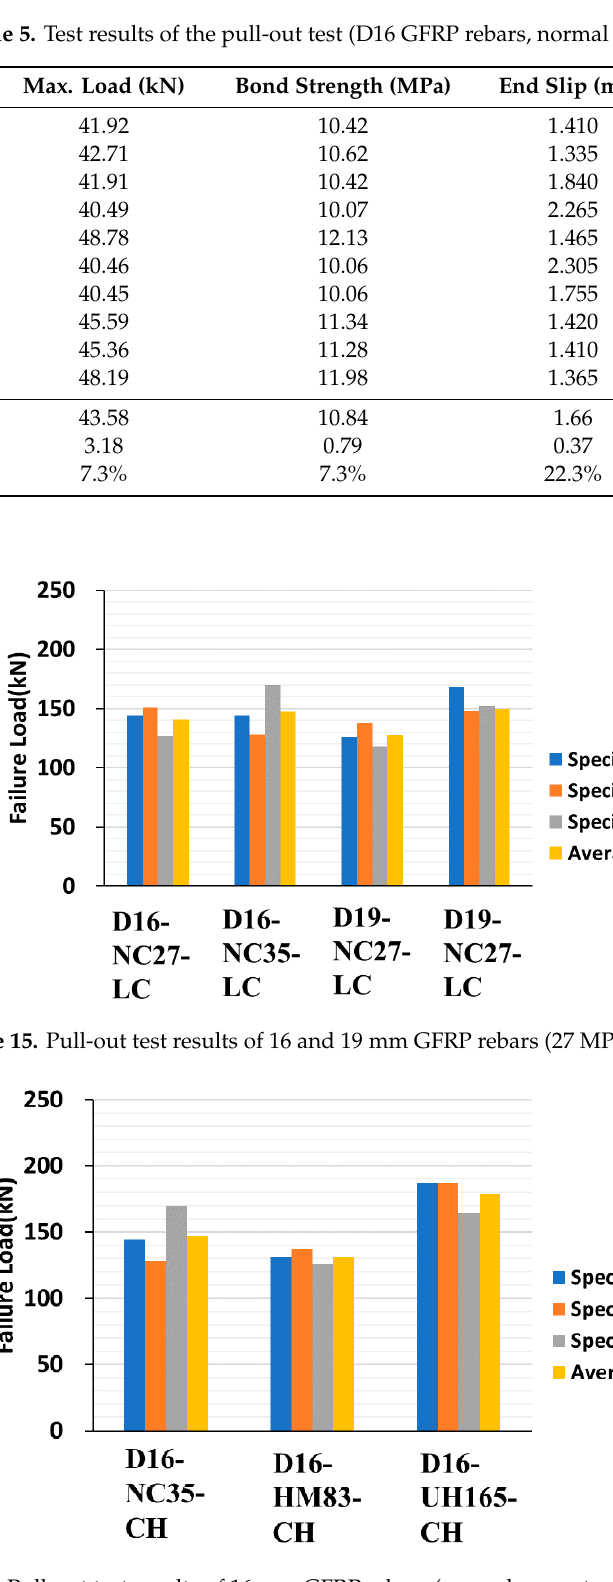
Figure 17. Pull-out test results of 19 mm GFRP rebars (normal concrete, mortar, UHPC).